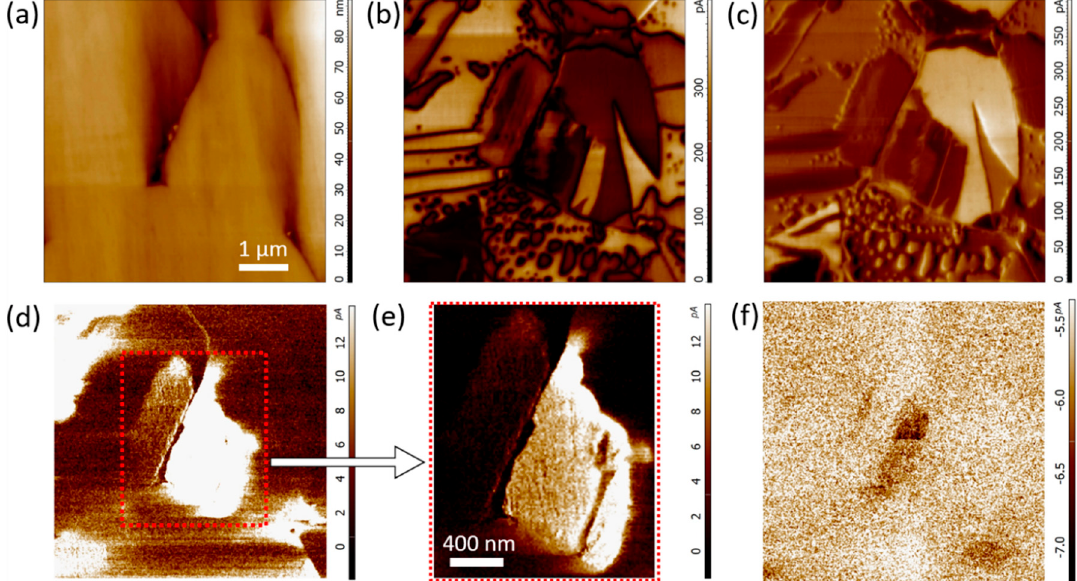
Figure 2. SPM measurements of the Bi 0.95 Ca 0.05 Fe 0.95 Ti 0.05 O 3 sample: ( a ) surface topography, ( b ) OOP PFM response, ( c ) IP PFM response, ( d ) c-AFM response at positive DC bias voltage of 5 V, ( e ) magnified c-AFM image of the area marked by the red dotted square in ( d ), ( f ) c-AFM response at negative DC bias voltage of − 5 V.